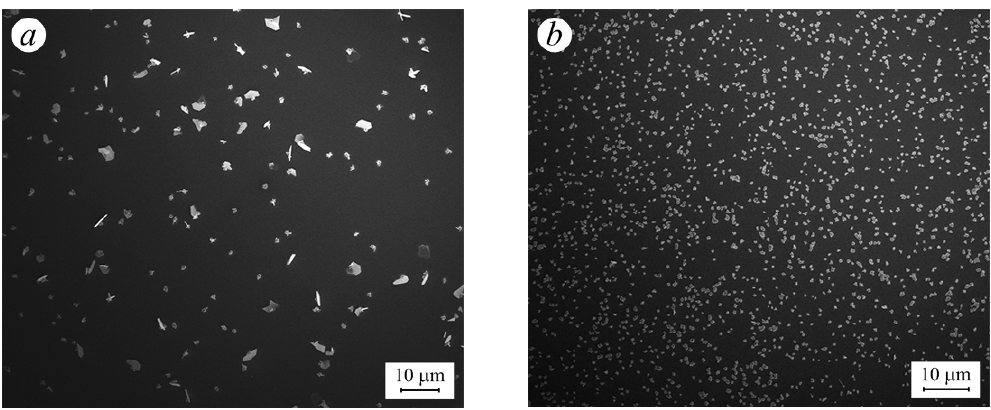
Figure 1. SEM images of ITO-glass surface after silver electrodeposition in acetonitrile solution of 0.01 M AgNO Depositions were carried out by pulse electrolysis under τ